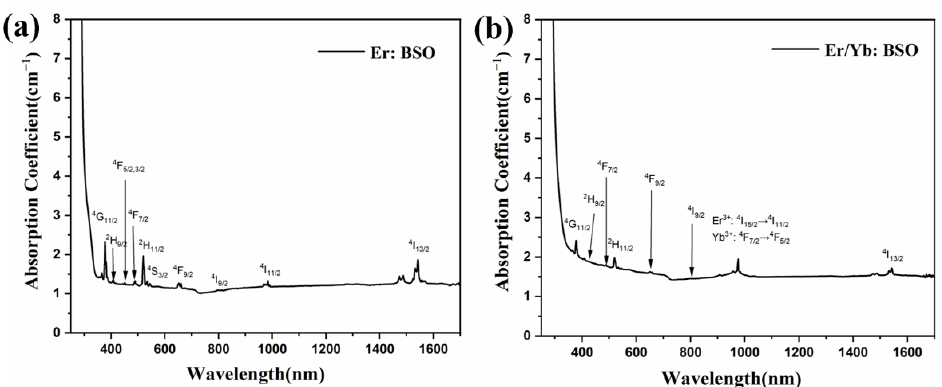
Figure 5. The absorption spectrum of ( a ) Er: BSO and ( b ) Er/Yb: BSO crystals.